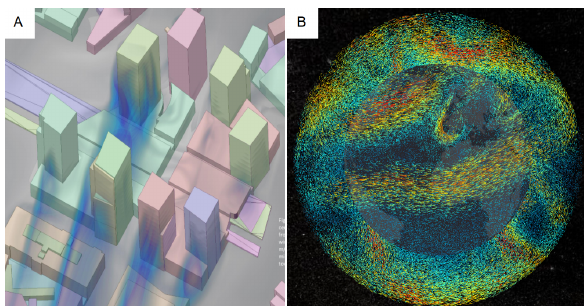
Figure 3. Representing 3D data as 3D fields; (A) using 3D continuous texture to represent 3D data. (Image from the Kalasatama Digital Twins Project, City of Helsinki); (B) using 3D fields of animated glyphs to represent 3D wind data (Li, Wang,